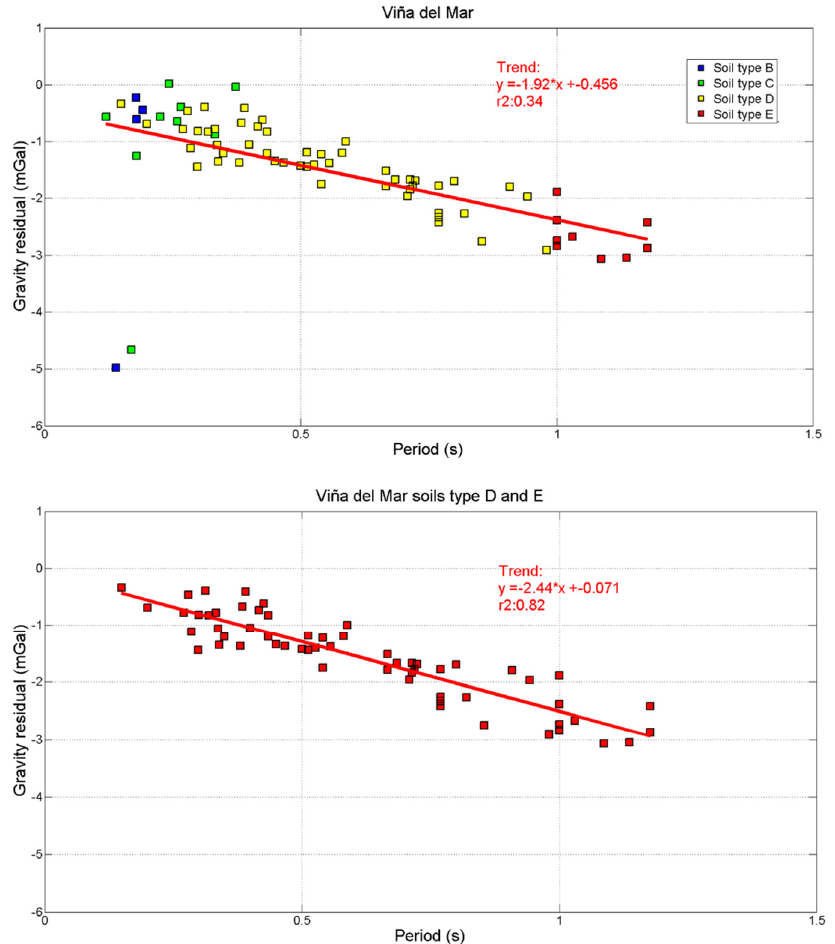
Figure 7. Correlation between gravity residuals and H/V predominant periods in Viña del Mar. Upper panel shows the results for all the type of sites presented in the area according to the seismic classification in Table 1. The lower panel shows the same results only for soft sites with classification of D and E.